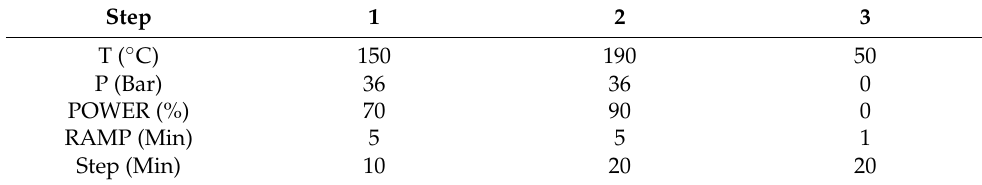
Table 2. Microwave digestor